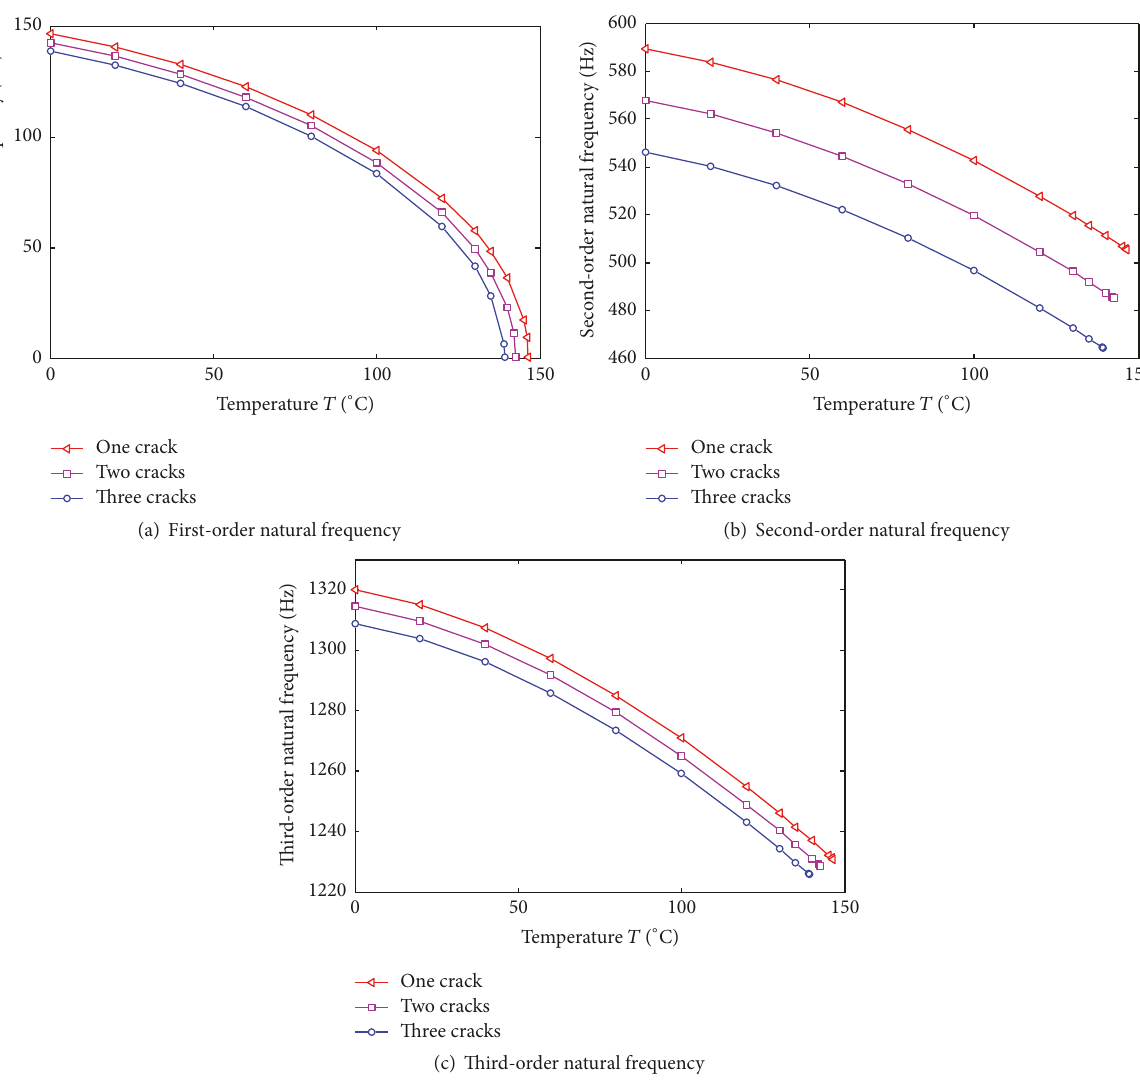
Figure 6: First three-order natural frequencies of the beam with different number of